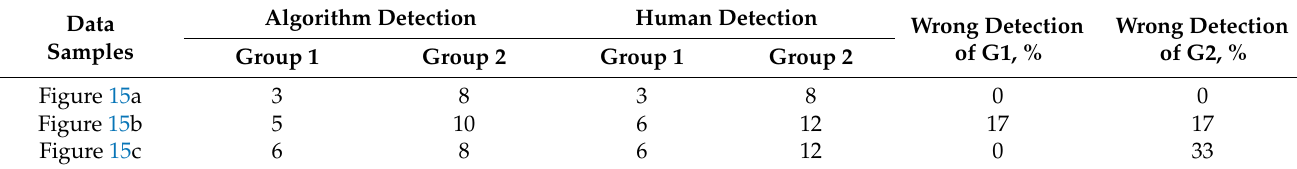
Figure 15. Classification of bagworm stages according to features extracted and marked with bounding box: ( a ) Test 1, ( b ) Test 2, and ( c ) Test 3. Table 4. Bagworm group classification performance between algorithm and human.